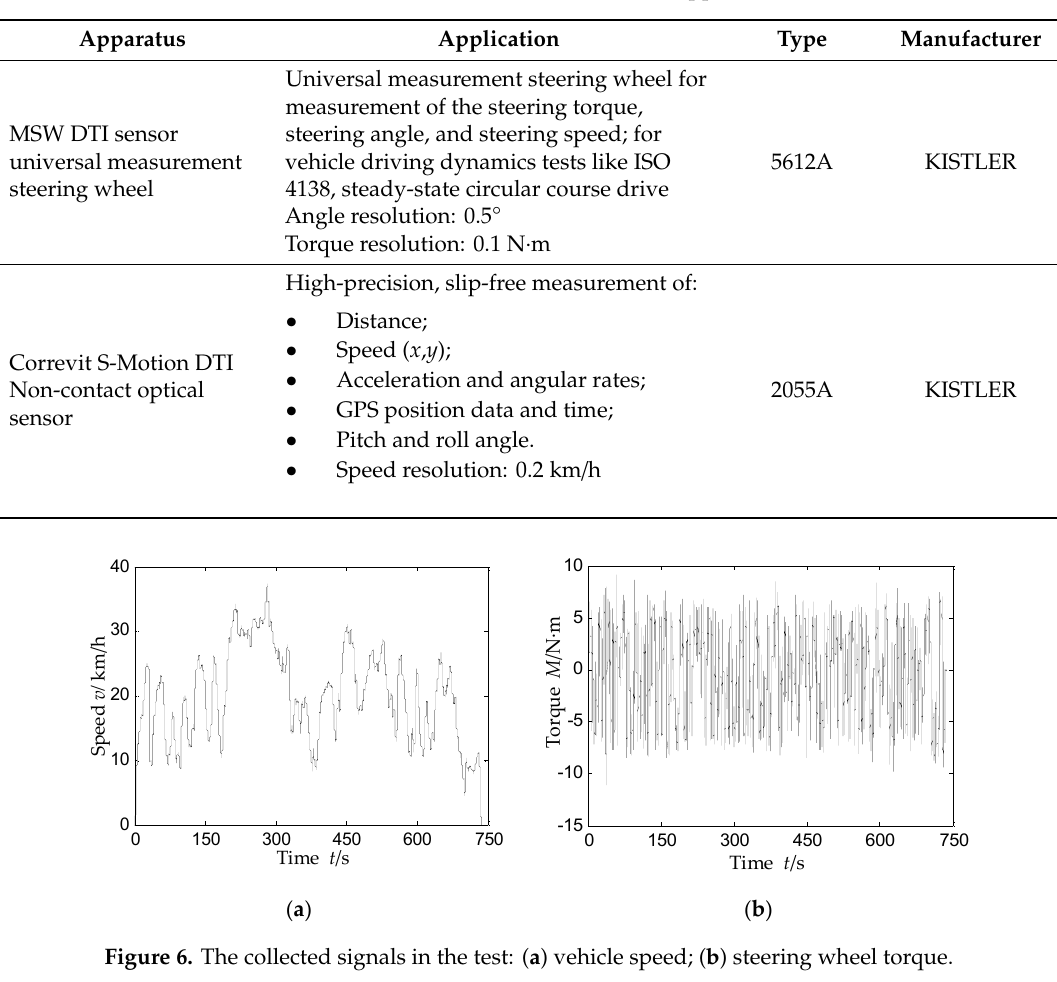
Table 3. The required current of EPS at different vehicle speeds. Vehicle Speed (km/h) 18.3 Figure 7. The assist characteristic model of EPS .